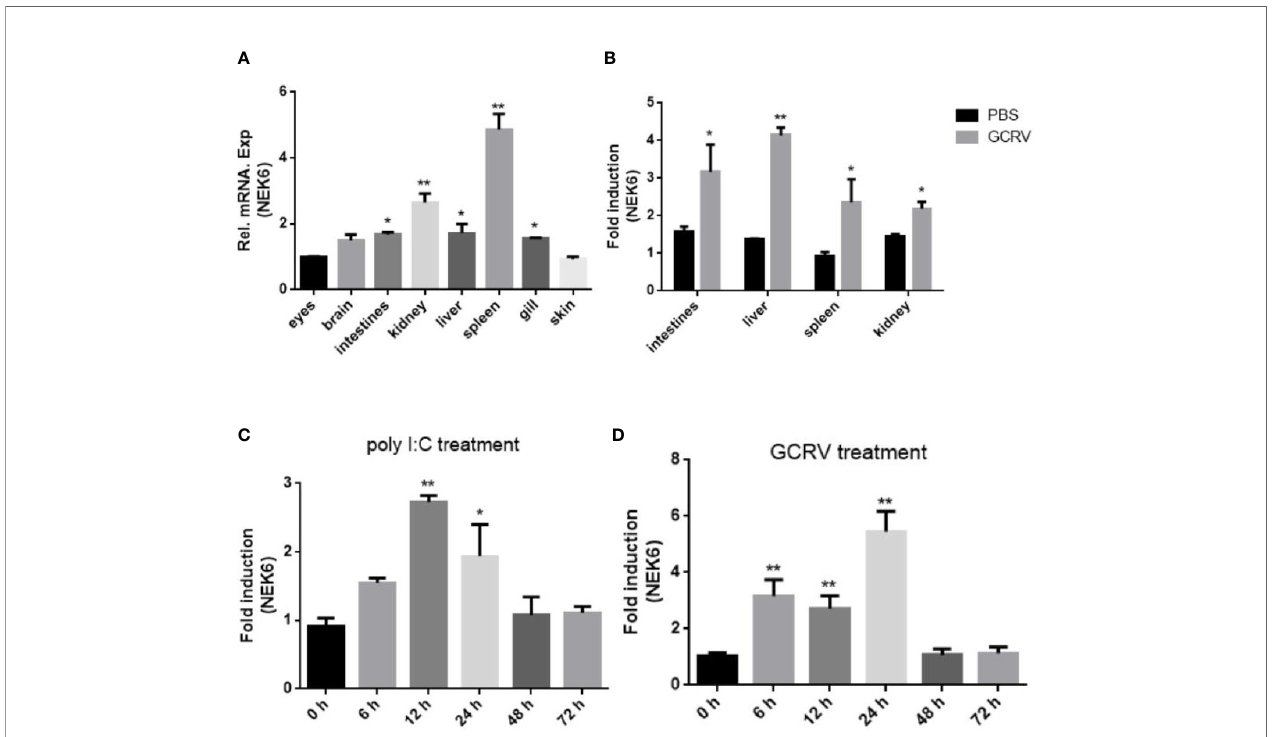
FIGURE 2 | The expression of CiNEK6 is up-regulated under GCRV and poly I:C treatment. The mRNA levels of CiNEK6 in grass carp tissues of eyes, brain, intestines, kidney, liver, spleen, gill and skin were detected at normal condition. The expression of CiNEK6 in eyes served as a control (A) . The tissues of intestines, kidney, liver and spleen were chosen to detect mRNA level of CiNEK6 at 24 h post-transfection after treatment with GCRV or PBS. The group of PBS treatment was a control (B) . CiNEK6 mRNA in CIK cells was monitored at different time point (0, 6, 12, 24, 48, and 72 h) of poly I:C (C) and GCRV (D) treatment. The group of 0 h was a control. *p < 0.05, **p <